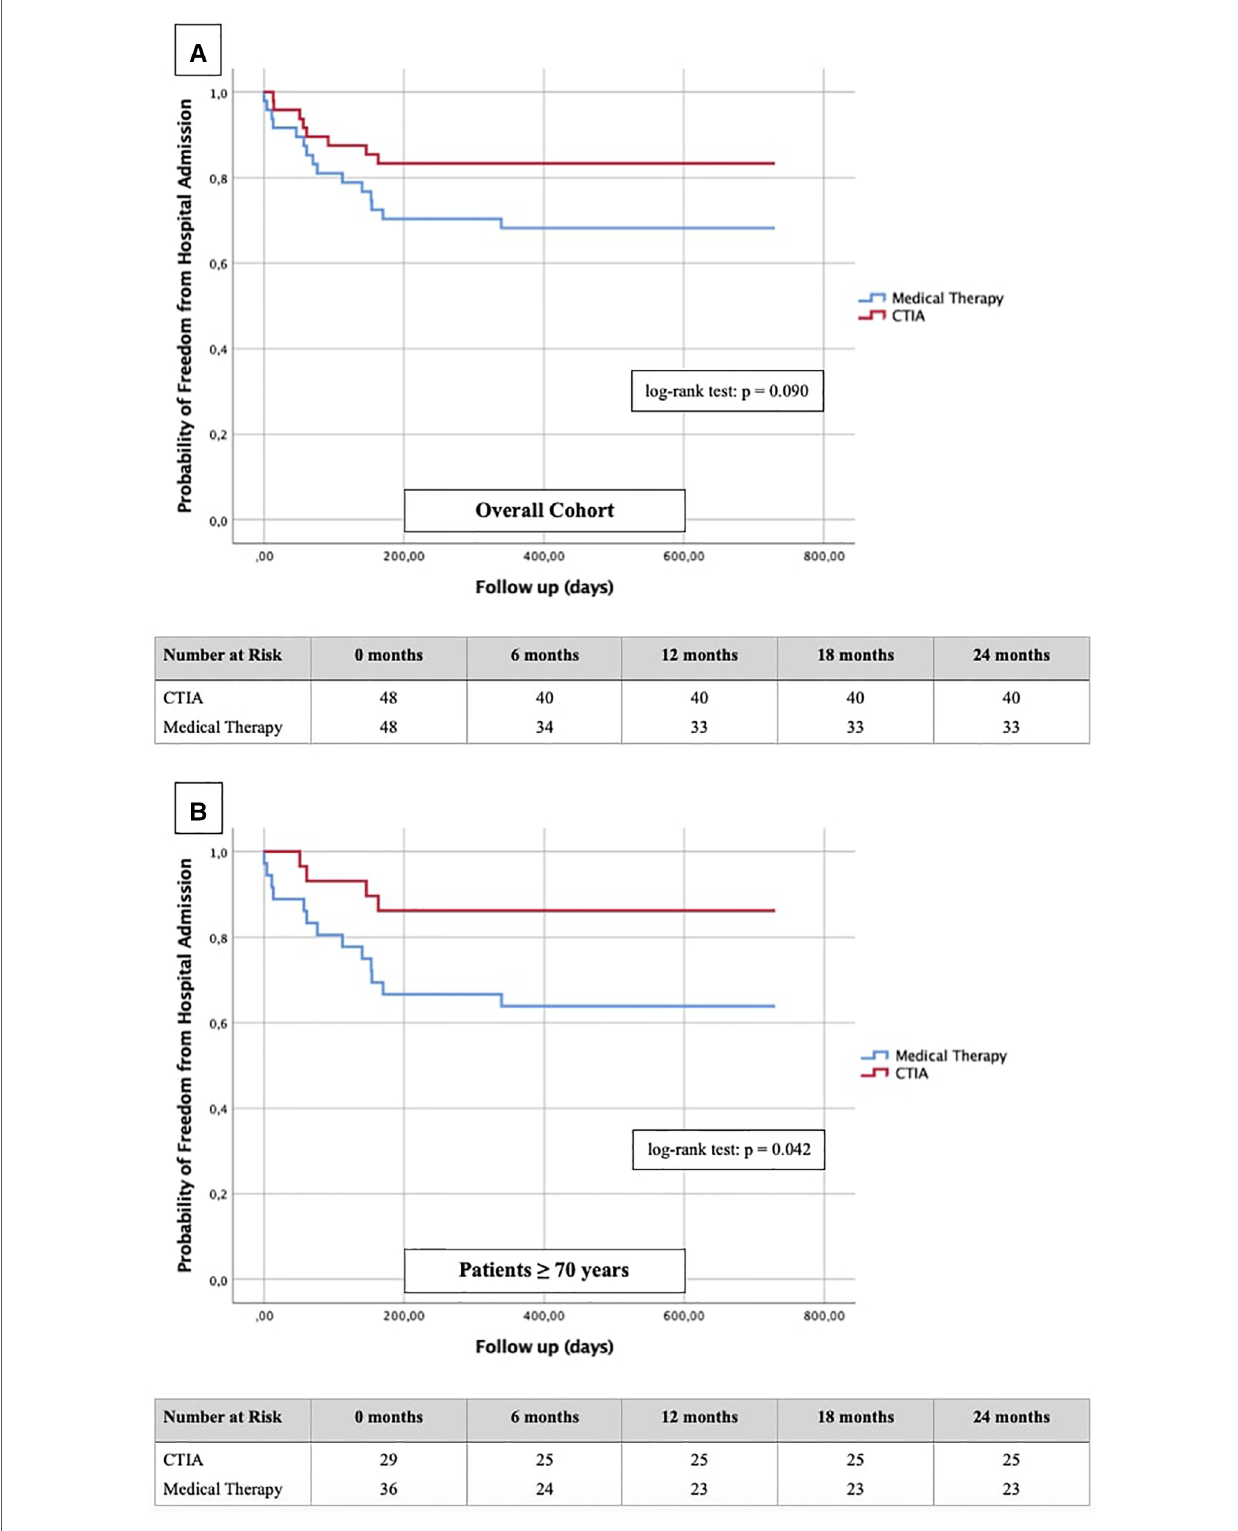
FIGURE 6 Kaplan-Meier curves with corresponding numbers at risk for detection of 2-year re-hospitalization rate regarding cardiovascular events in dependence of ablation vs. medical therapy.